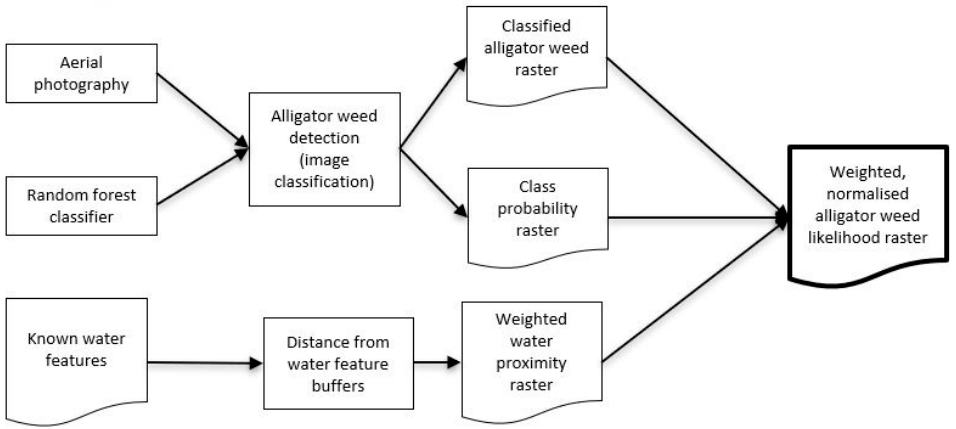
Figure 2. Overview of the alligator weed aerial remote sensing detection classification workflow.